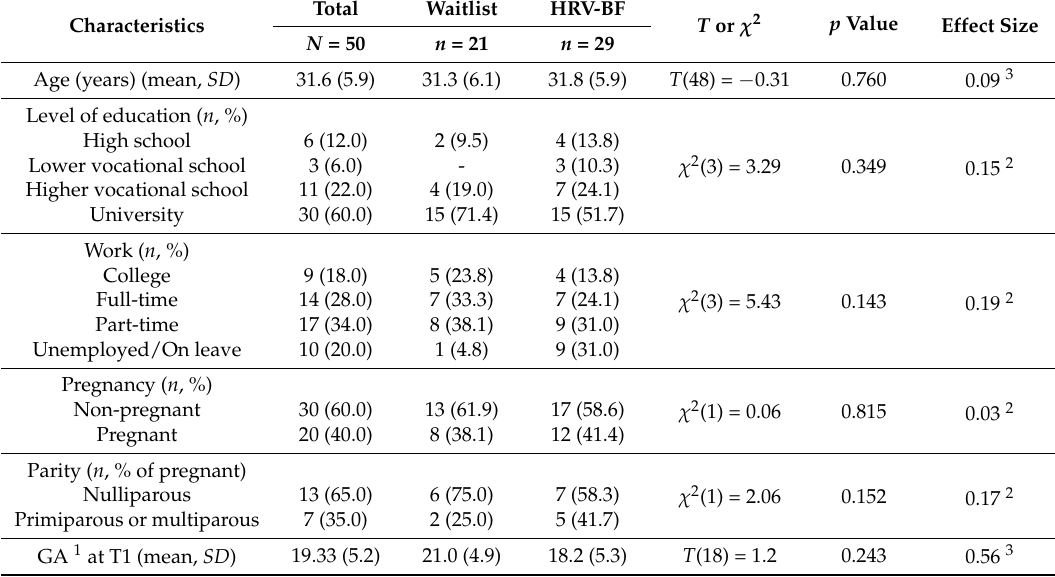
Table 1. Demographic characteristics of participants in the waitlist and heart rate variability biofeedback (HRV-BF) condition at T1.